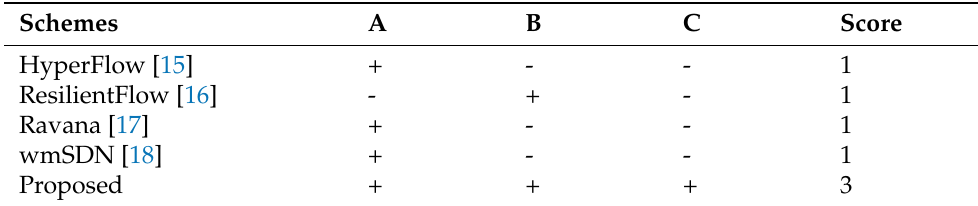
Table 2. Comparative analysis of hSDN